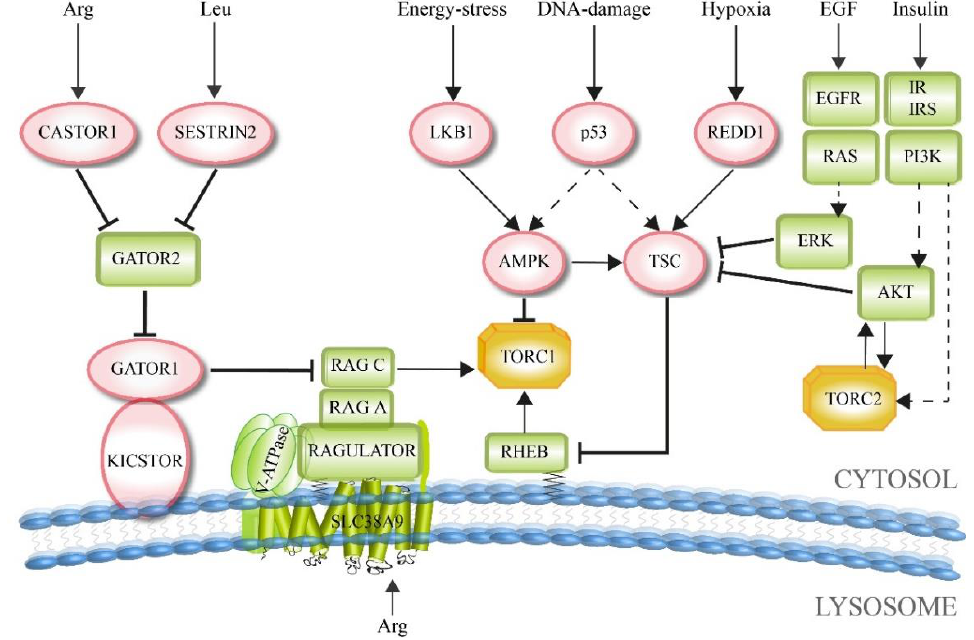
Figure 3. Upstream factors of the TOR pathway. The most important factors required for the signal integration of different stimuli by TORC1 and TORC2 are shown. Factors that enhance TOR activity are shown in squares, while those that hamper TOR activity are shown in circles. Dashed lines: effect mediated via additional proteins that are not depicted in the figure.